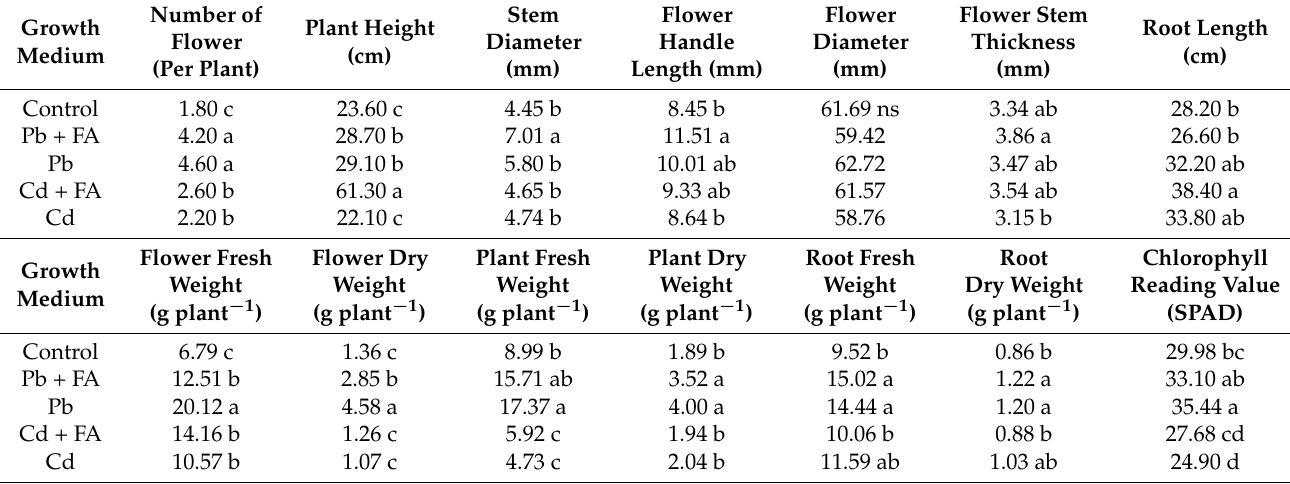
Table 2. Effect of different growing medium on growth parameters of Zinnia elegans